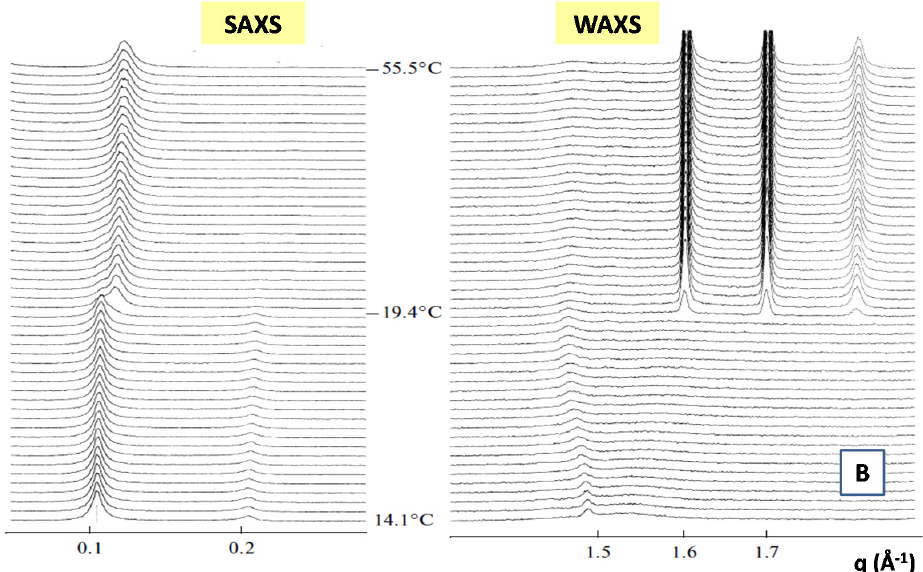
Figure 7. Main structural phases in water solution of a 1,2-dipalmitoyl-sn-glycero-3-phosphocholine (DPPC) lipid system ( A ). Time evolution of the SAXS and WAXS spectra of multilamellar DPPC vesicles during the cooling from temperature T = 14 °C to T = − 55.5 °C (Adapted from Kiselev [99]) ( B ). The cooling rate is 1.5 °C/min and data acquisition time is 1 min for each spectrum. The SAXS spectra in the temperature range from T = 14.1 to T = − 19.4 °C evidence the beginning